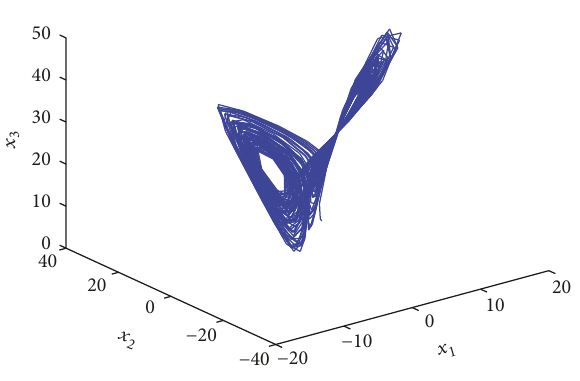
Figure 1: The chaotic trajectory of Lorenz systems.